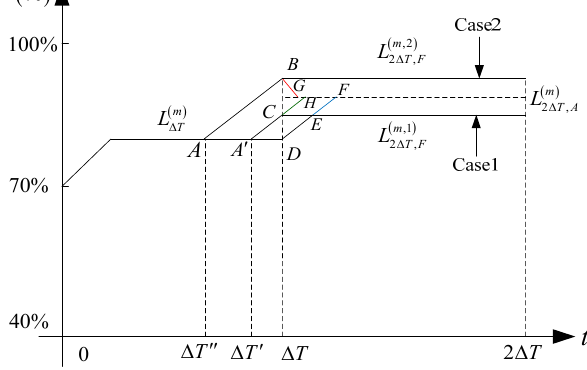
Figure 6. Dynamic modification of CHP based on actual and forecasted prices.